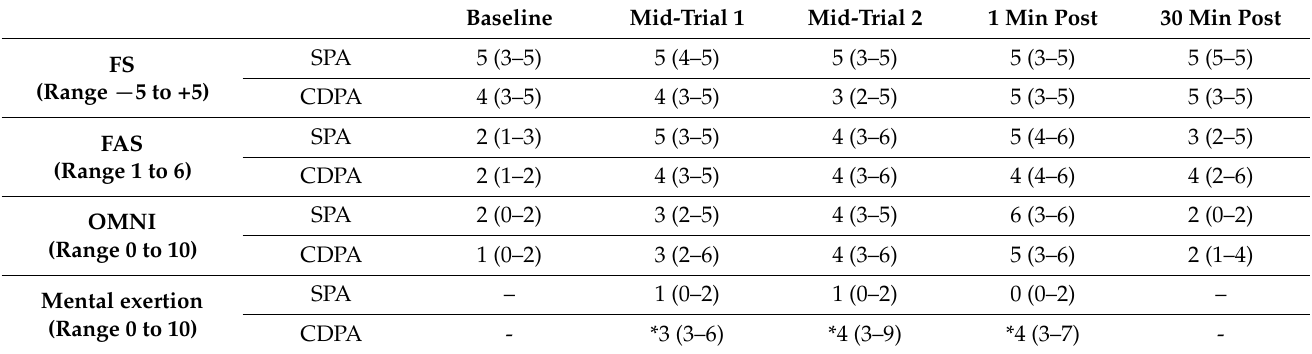
Table 3. The affect scales (feeling scale (FS) and felt arousal scale (FAS)), OMNI and mental exertion for SPA and CDPA are represented by medians and interquartile ranges (25% and 75% percentile). Baseline Mid-Trial 1 1 Min